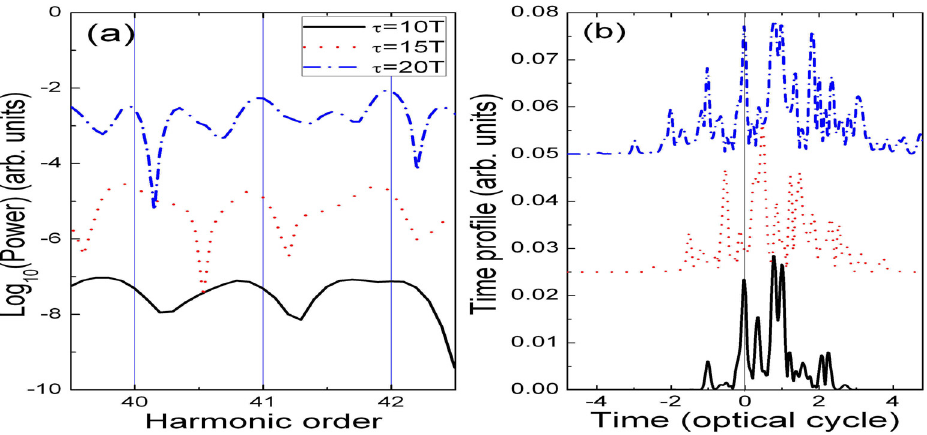
Figure 5. ( a ) Red shifted harmonics in the plateau with order N = 40–42 at different laser pulse durations τ . With increasing the pulse duration, the nonadiabatic effect is reducing and the redshift of the harmonics becomes smaller. ( b ) The corresponding time profiles of harmonic order N = 40. When the laser pulse duartion is increased, more harmonics generated with 0 t  , and the asymmetry between 0 t  and 0 t  is less, which reduces the red shift of the harmonics. The curves have been shifted vertically for